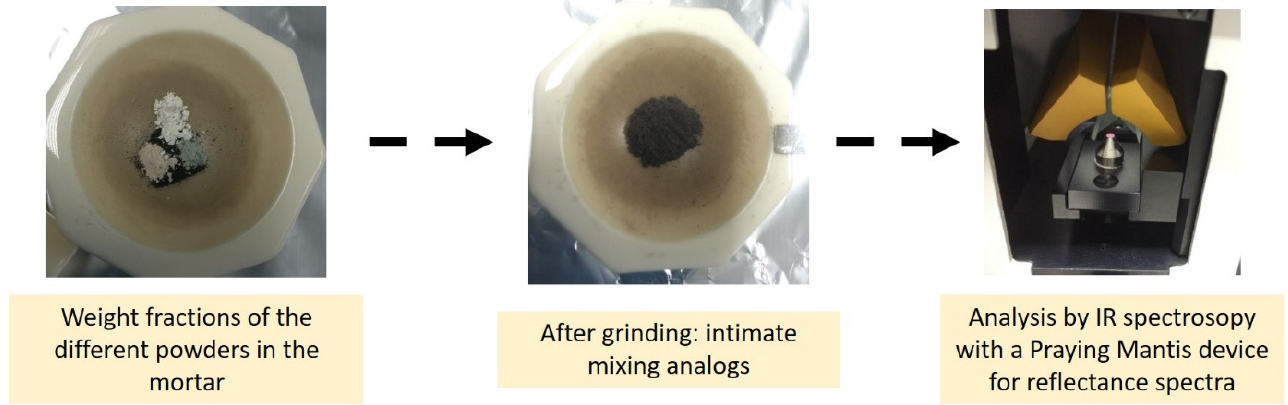
Figure 4. Schematic representation of the protocol. Left and center: preparation of the mixtures by grinding the different components (after weighing) into a mortar (35 mm diameter); right: analysis in reflectance by IR spectroscopy with a Praying Mantis device.